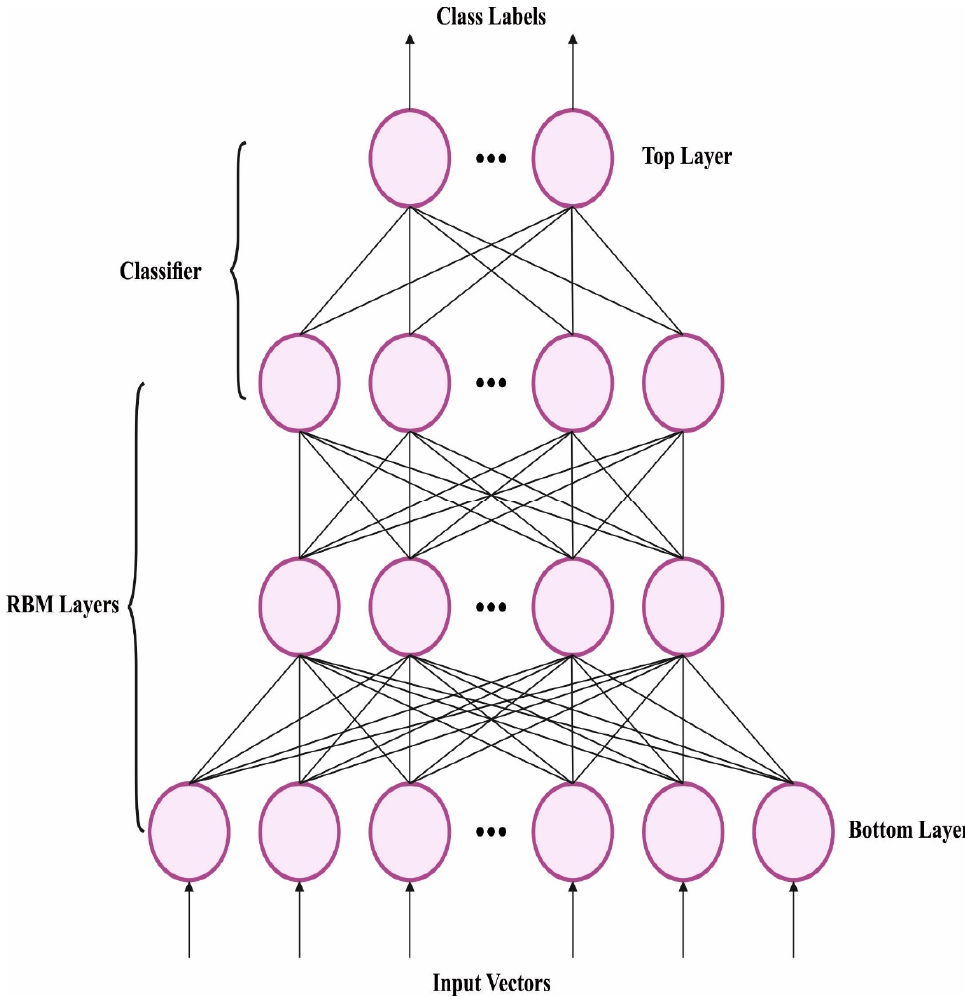
Figure 2. Framework of DBN.